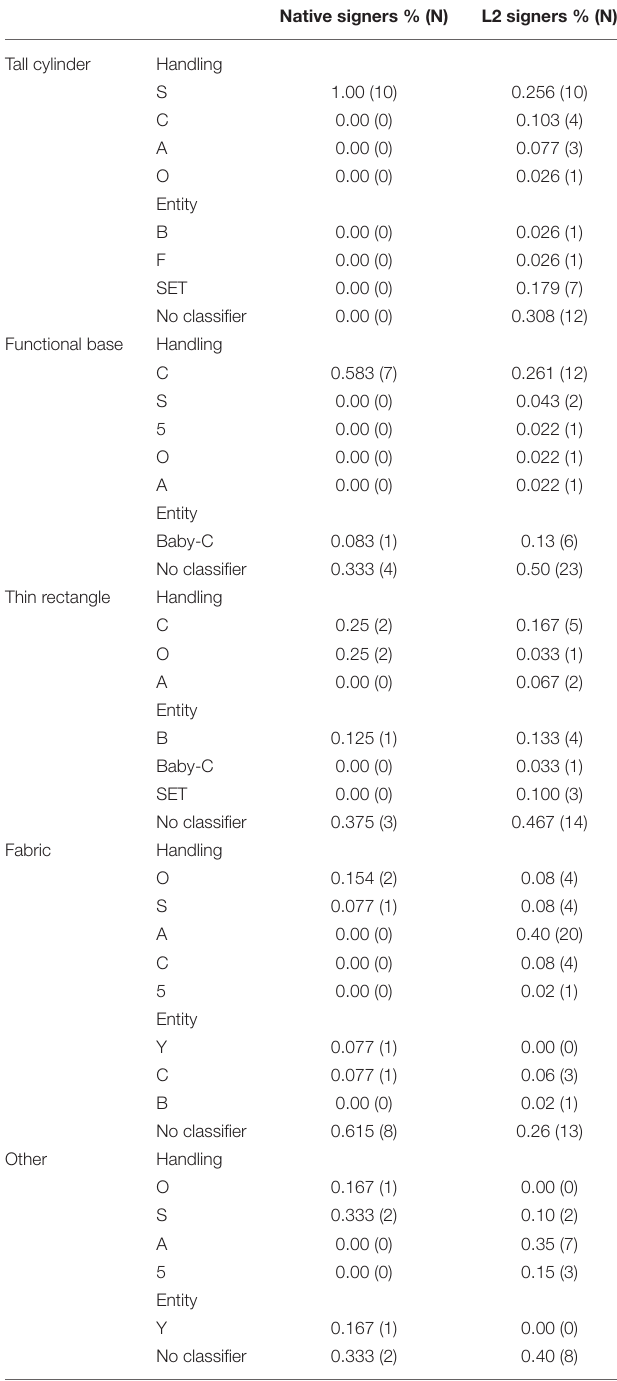
TABLE 4 | Classifier types by group and object